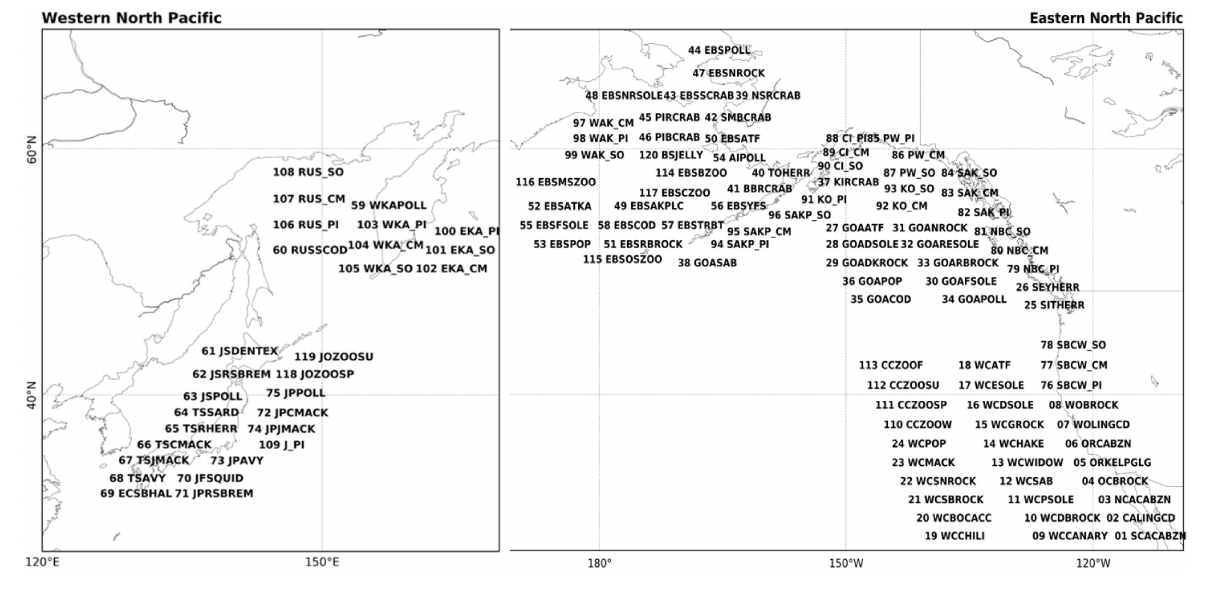
Frontiers in Marine Science |